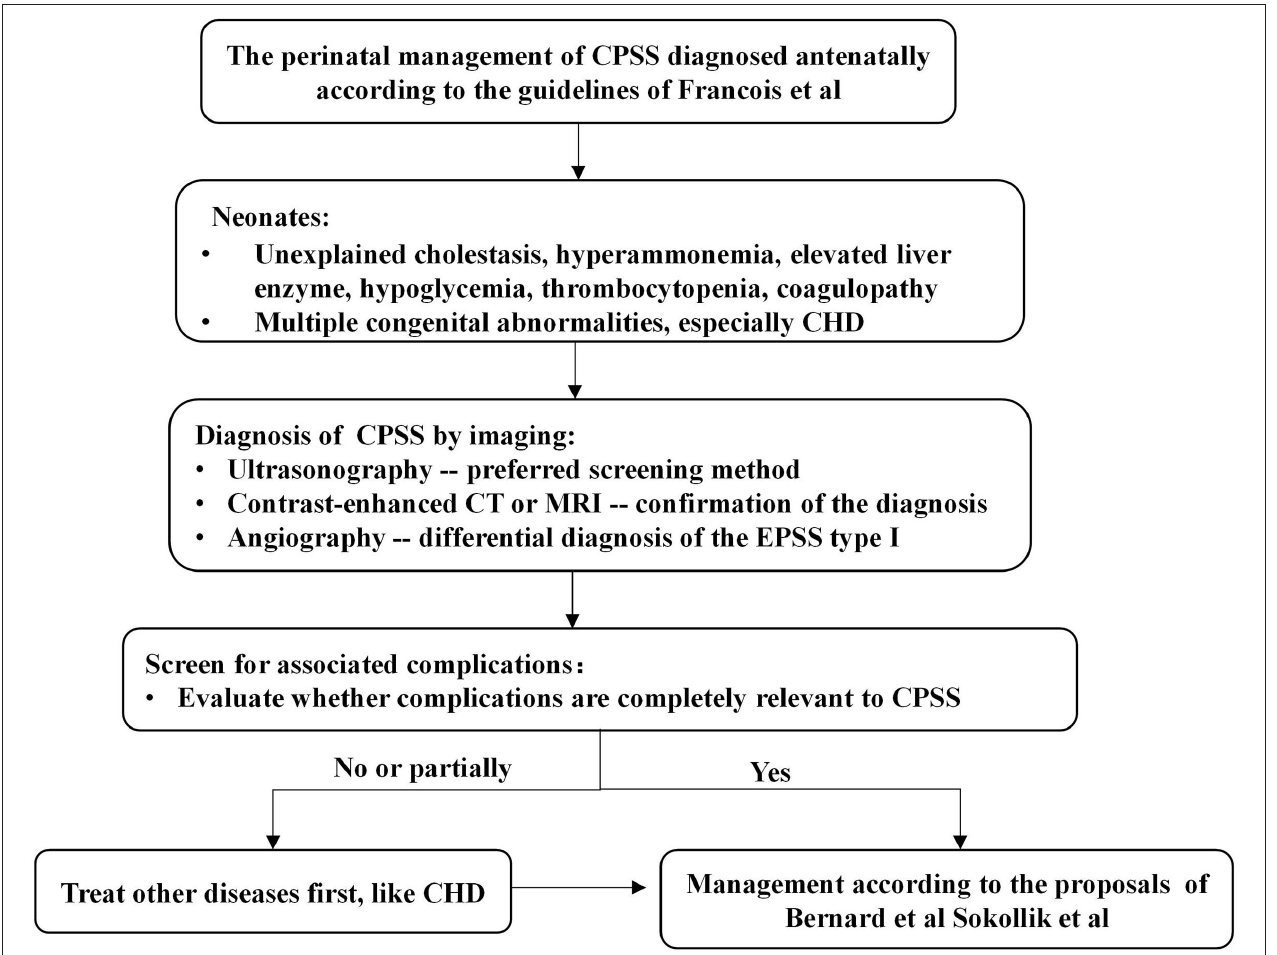
FIGURE 2 | Algorithm for the management in a neonate with CPSS. Francois et al. (3), Bernard et al. (1), and Sokollik et al. (2). CHD, congenital heart disease; CPSS, congenital portosystemic shunts; CT, computerized tomography; MRI, magnetic resonance